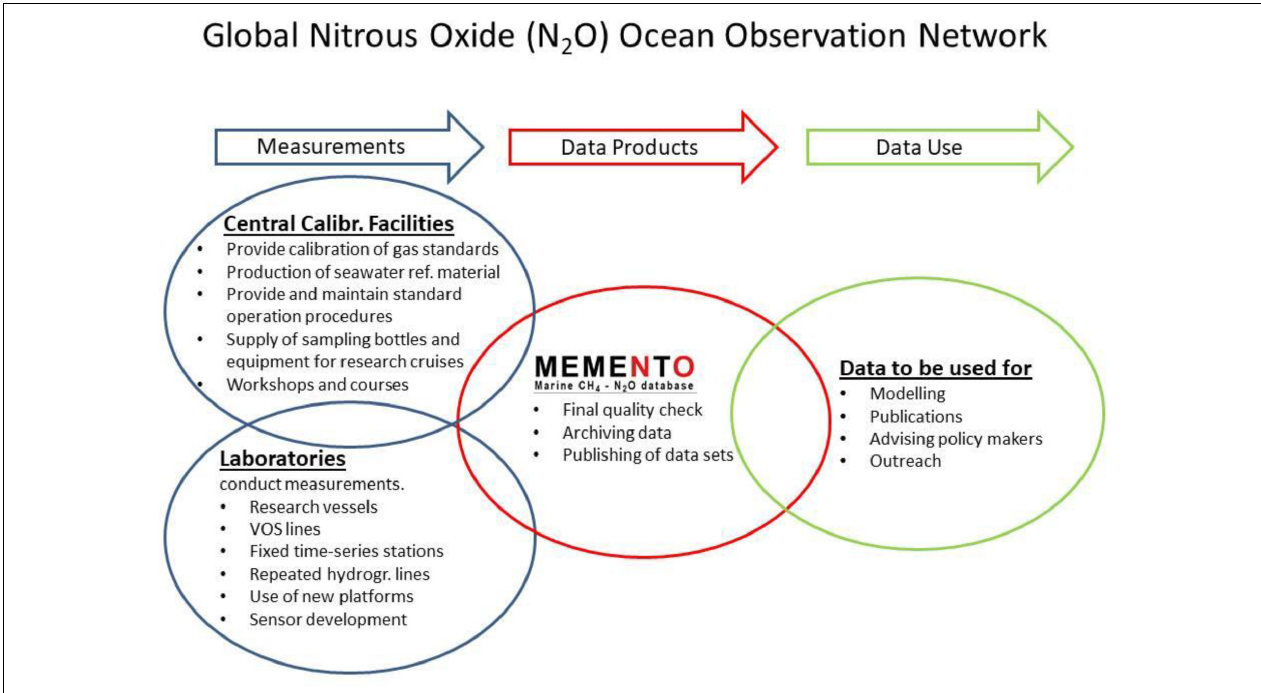
FIGURE 3 | Proposed scheme for the Global N 2 O Ocean Observation Network. MEMENTO stands for “MarinE MethanE and NiTrous Oxide” database: